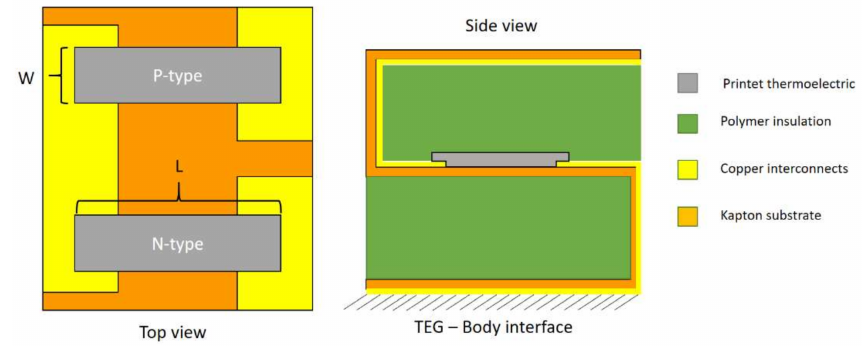
Figure 4. Device configuration and printed thermocouples-interconnects